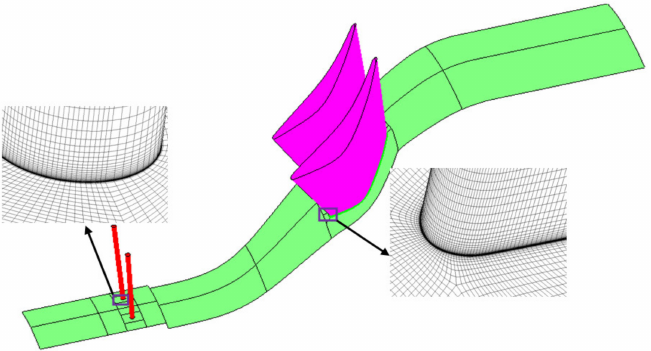
Figure 4. Calculation domain and grid of the integrated